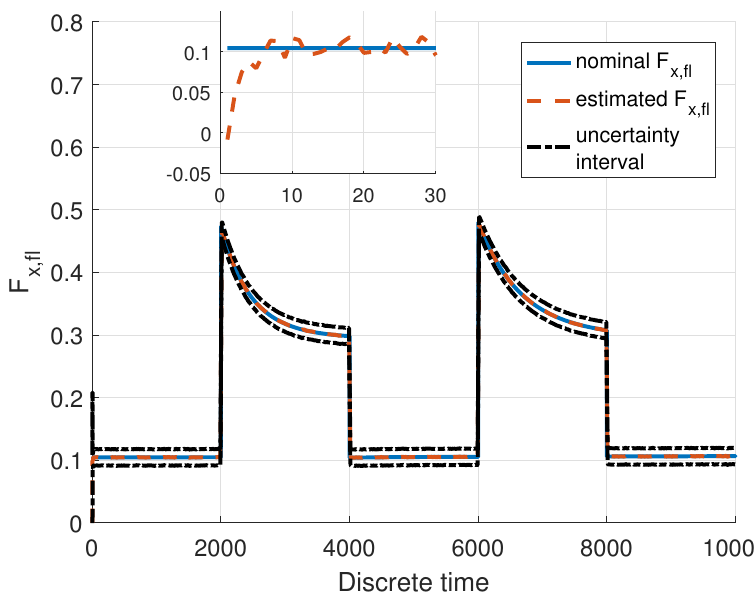
Figure 4. Nominal and estimated F x , fl .